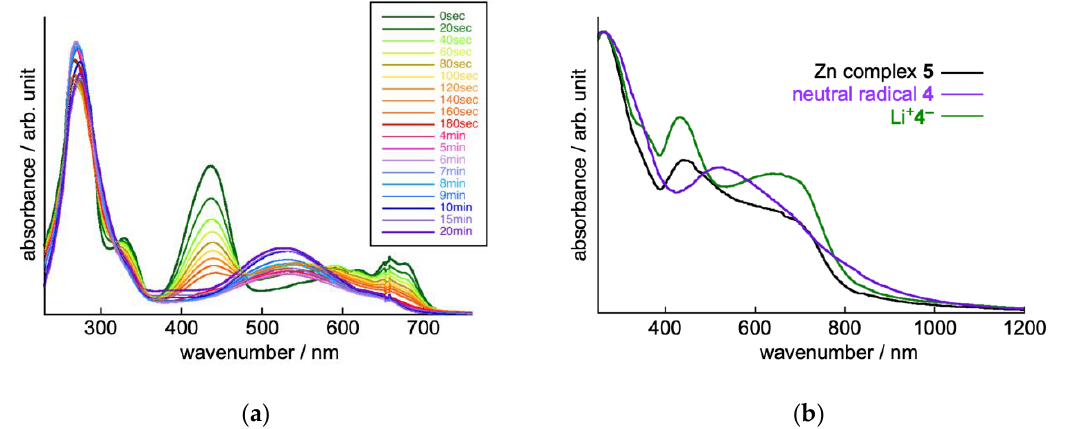
Figure 3. ( a ) Changes in the UV-Vis/near-IR spectra during the electrochemical oxidation of [( n - Hex) 4 N + ]( 4 − ) in CH 2 Cl 2 containing 0.1 M ( n -Bu) 4 N + PF 4 . The green and purple lines show the spectra recorded before and after the application of an external potential of +1.2 V vs. Ag/AgNO 3 ; ( b ) Solid- state electronic spectra of Li + 4 − , neutral radical 4 and zinc(II) complex 5 in potassium bromide (KBr) pellets. All spectra were measured at room temperature.